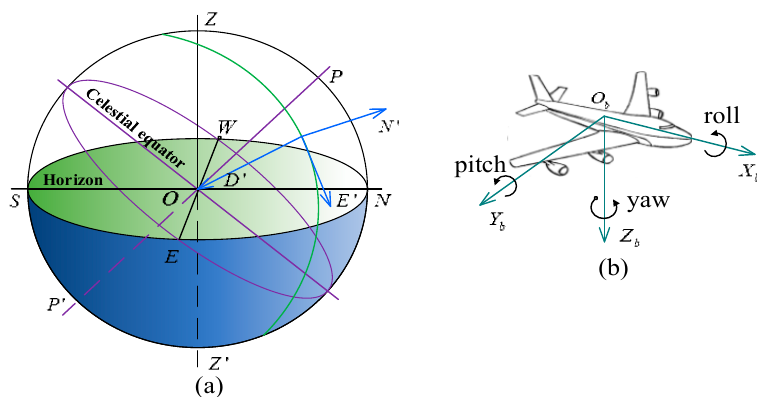
Figure 1. Definition of coordinate systems and carrier attitude angles: ( a ) local geographical coordinate system ( N’E’D’ ) defined relative to the geoid; ( b ) carrier coordinate system ( X b Y b Z b ) and carrier attitude angles including roll, pitch and yaw angles.